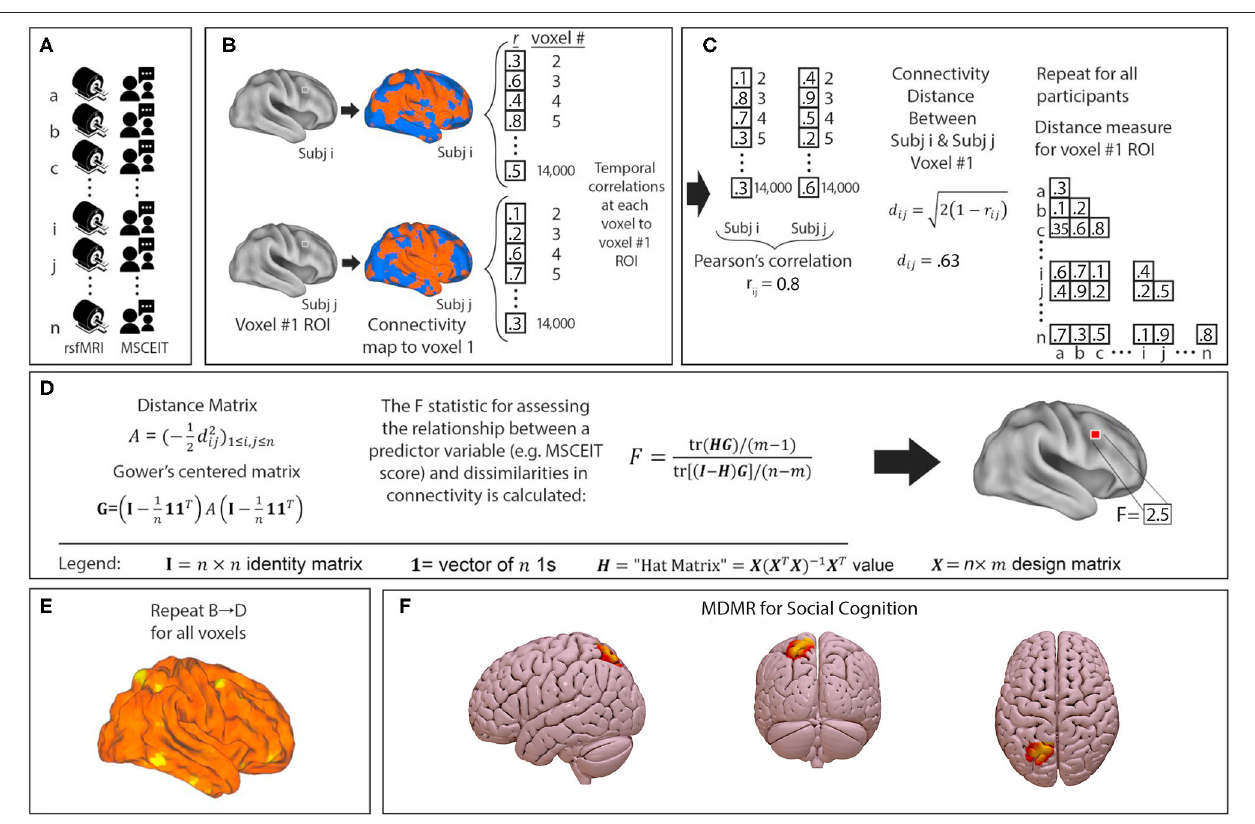
FIGURE 1 | Multivariate distance matrix regression identifies left parietal connectivity as the strongest correlate of social cognitive ability in a trans-diagnostic sample. MDMR procedure: (A) rsfMRI and emotional intelligence testing are collected from each participant. (B) For each participant a functional connectivity map is generated to an individual voxel. (C) Voxelwise temporal correlations between participants are used to generate a Pearson’s correlation r and a distance metric d . This is repeated for all participants to generate a matrix of between subject distances. (D) The distance matrix is centered and an ANOVA-like test is used to generate an F -statistic to assess the relationship between a predictor variable (MSCEIT-ME score) and dissimilarities in functional connectivity at that voxel. (E) This process is repeated for every voxel. This results in a whole brain map of how significantly functional connectivity is related to emotional intelligence. Permutation testing then identifies whole-brain significant clusters in connectivity-MSCEIT-ME relationships. (F) In our sample of 126 participants ( n = 60 with schizophrenia or schizoaffective disorder, n = 21 with bipolar disorder with psychosis, and n = 45 neurotypical participants), we identified a single region in the left parietal lobule (centered at MNI coordinates x – 24 y – 69 z + 57) whose connectivity correlated significantly with emotional intelligence. In this image, connectivity is thresholded at a voxelwise level of p < 0.001 and extent threshold of p < 0.05.